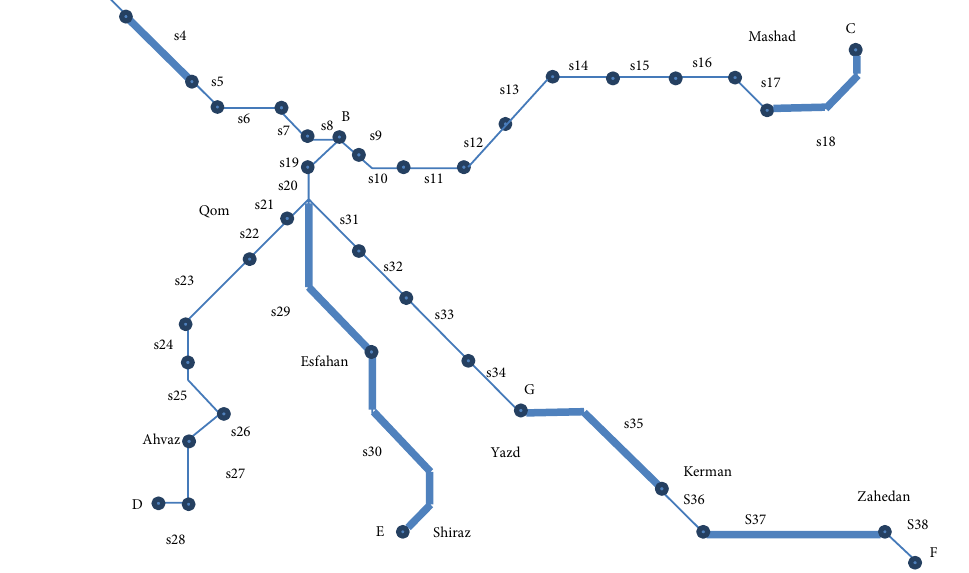
Fig. 5. Expanded network (equal